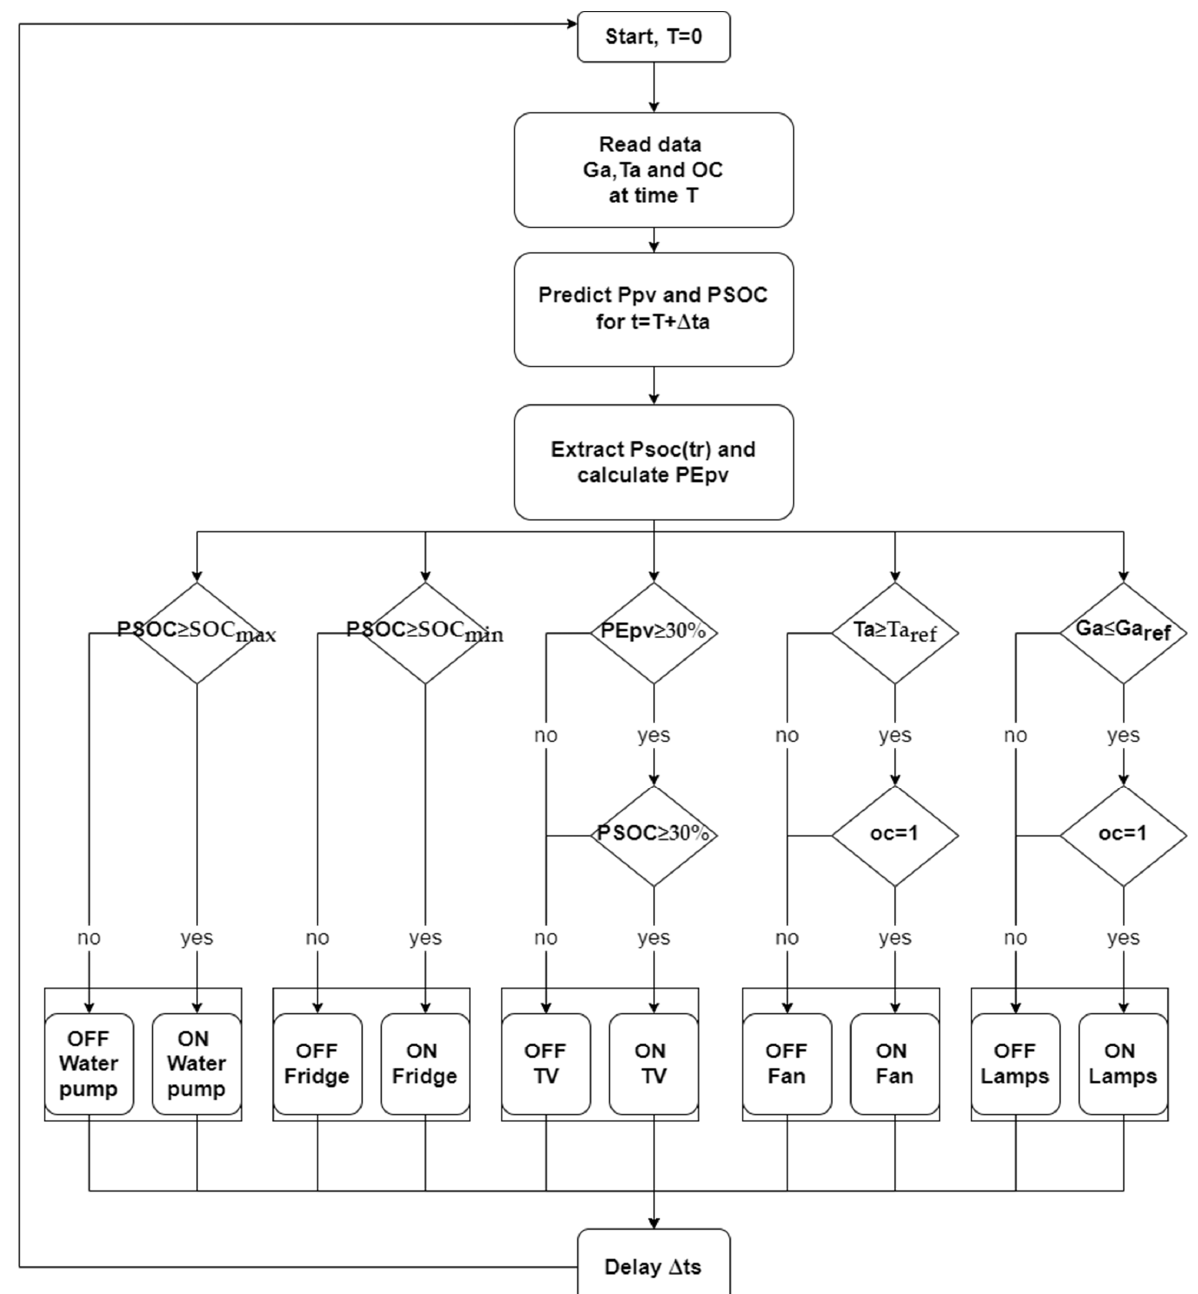
Figure 3. The load management strategy flowchart.